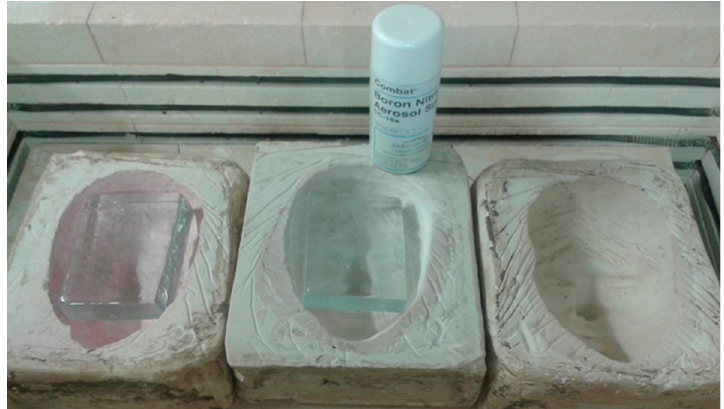
Figure 11. Three types of separators: boron nitride, a slab of cast glass from furnace, and only 1% kiln wash, and/or China clay in the mold mixture; created by author.